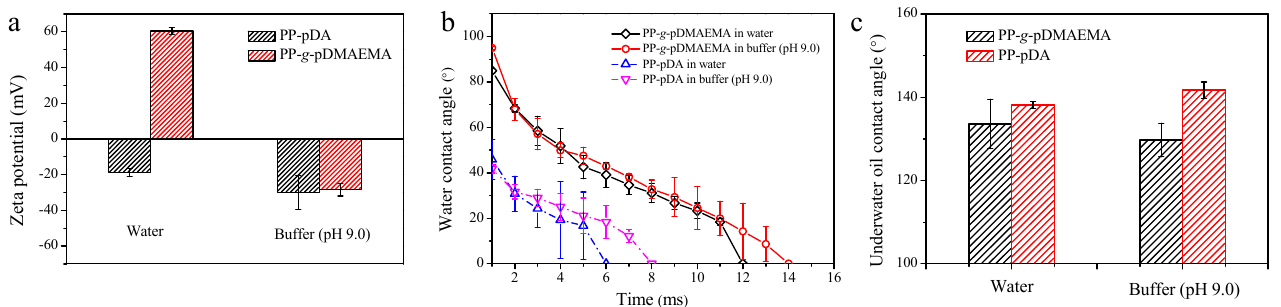
Figure 3. ( a ) The surface zeta potential of membranes; ( b ) the water contact angle and wicking curve of membranes; ( c ) the underwater oil contact angle of membranes in different pH.3.2. Emulsion Separation Performance of the PP-g- pDMAEMA Membrane.